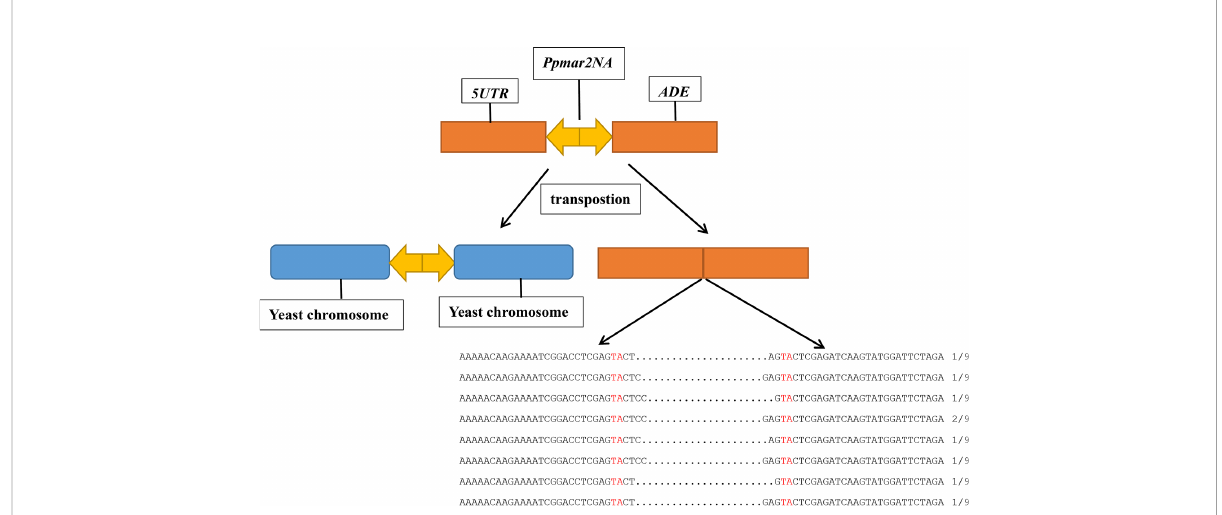
FIGURE 1 Sequence alignment of Ppmar2NA at excision spots on pWL89a. Sequences of Ppmar2NA at excision spots were ampli fi ed using primers yeast T-5 and T-3. The TA-target sites of TSDs are marked in red, and the interval between the red TA represents the footprints after